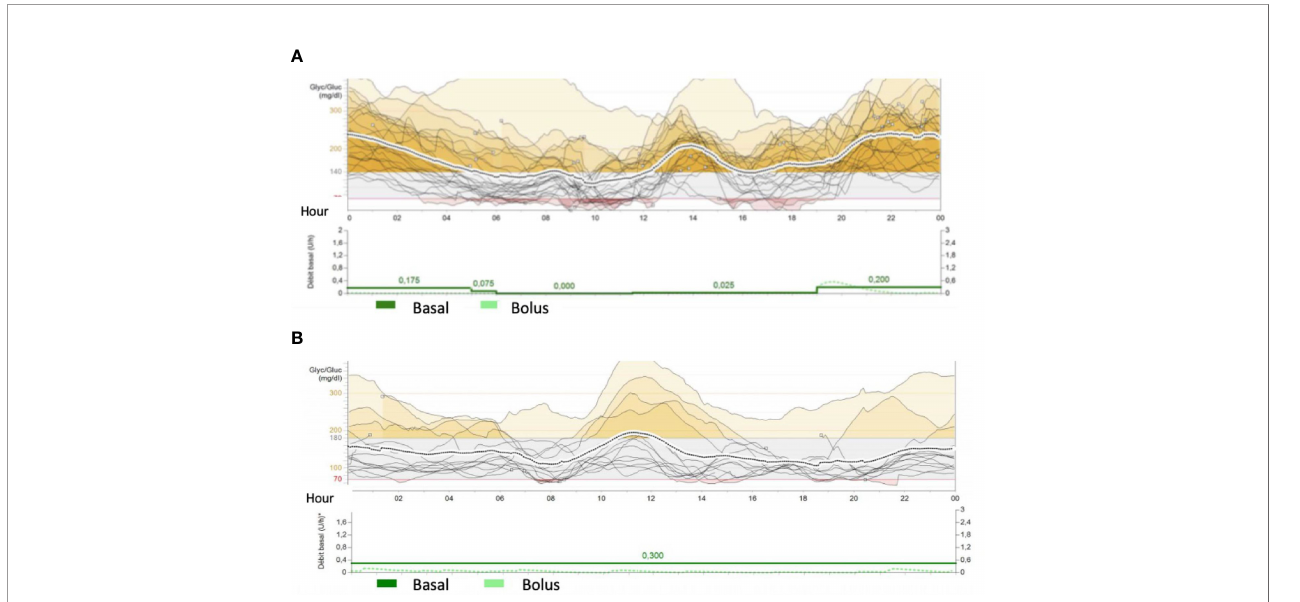
FIGURE 3 | Conti nous Glucose Monitoring da ta from Mini Med 640G System from patients 3- M utR181W (A) and 4- (c.505-2A>G/ c.2782A>G ) (B) . The traces represents glucose variability during the day. Red colour cshowed hypoglycemic periods (less than 70mg/dl) and yellow periods represents hyperglycemias ( more than 140-180 mg/dl) In fi gure (A) , patient 3 presents recurrent hypoglycemic episodes during daily period when she was disconnect from parenteral nutrition (4 a.m.) and frequent hyperglycemia during night period. Basal rate was 0.2UI of insulin during parenteral nutrition (around 10 times more than during the day) Patient 4 had lower glycemic variability, but some hypoglycemia du ring the day. He received parenteral nutrition and few oral